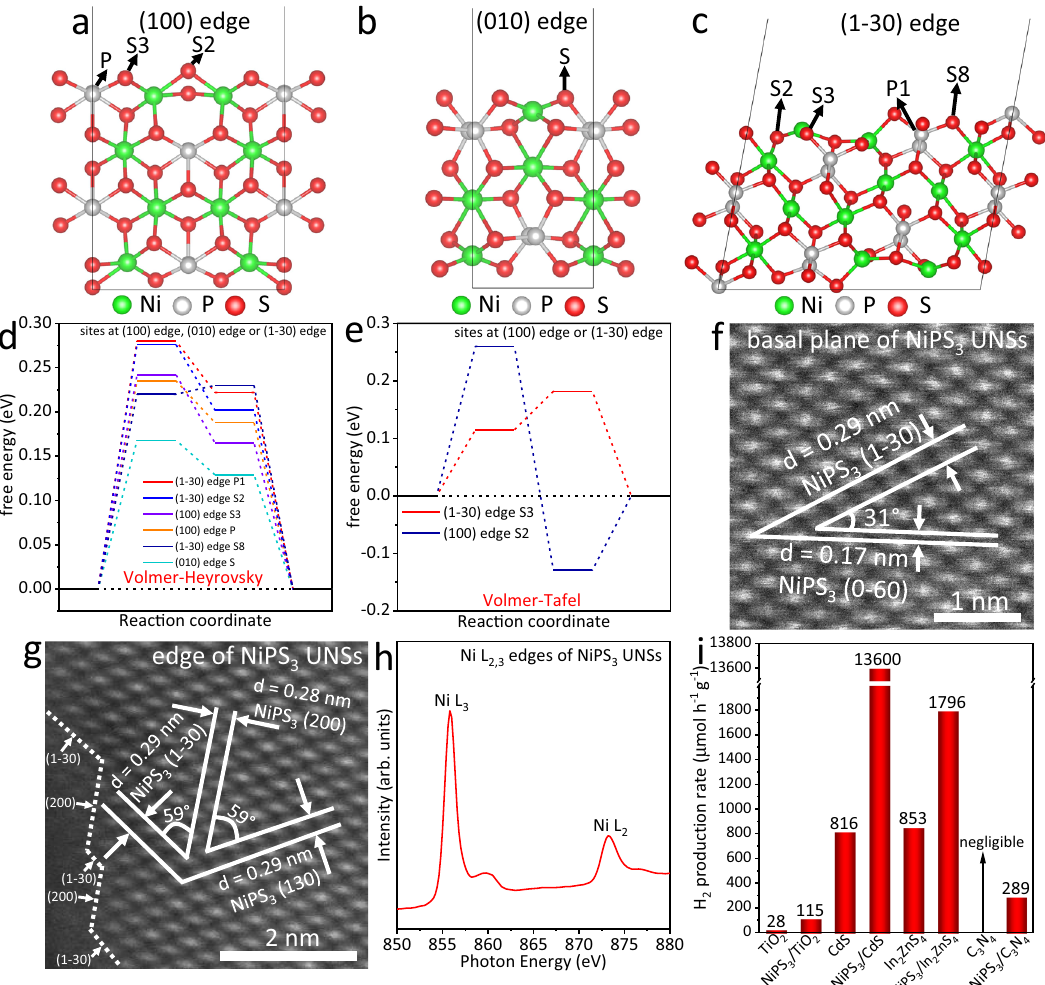
Fig. 1 | Theoreticalprediction, characterizationand applicationofNiPS 3 UNSs. a ActiveP,S2andS3sitesforHERat(100)edgeofNiPS 3 monolayer. b ActiveSsite forHERat(010)edgeofNiPS 3 monolayer. c ActiveP1,S2,S3andS8sitesforHERat (1 – 30) edge of NiPS 3 monolayer. d Gibbs free energy diagrams for HER following the Volmer – Heyrovsky pathway on the active sites at (100) edge, (010) edge or (1 − 30) edge of NiPS 3 monolayer. e Gibbs free energy diagrams for HER following the Volmer – Tafel pathway on the active sites at (100) or (1 − 30) edge of NiPS 3 monolayer.Atomic-resolutionHAADF-STEMimagesfor f basalplaneand g edgeof